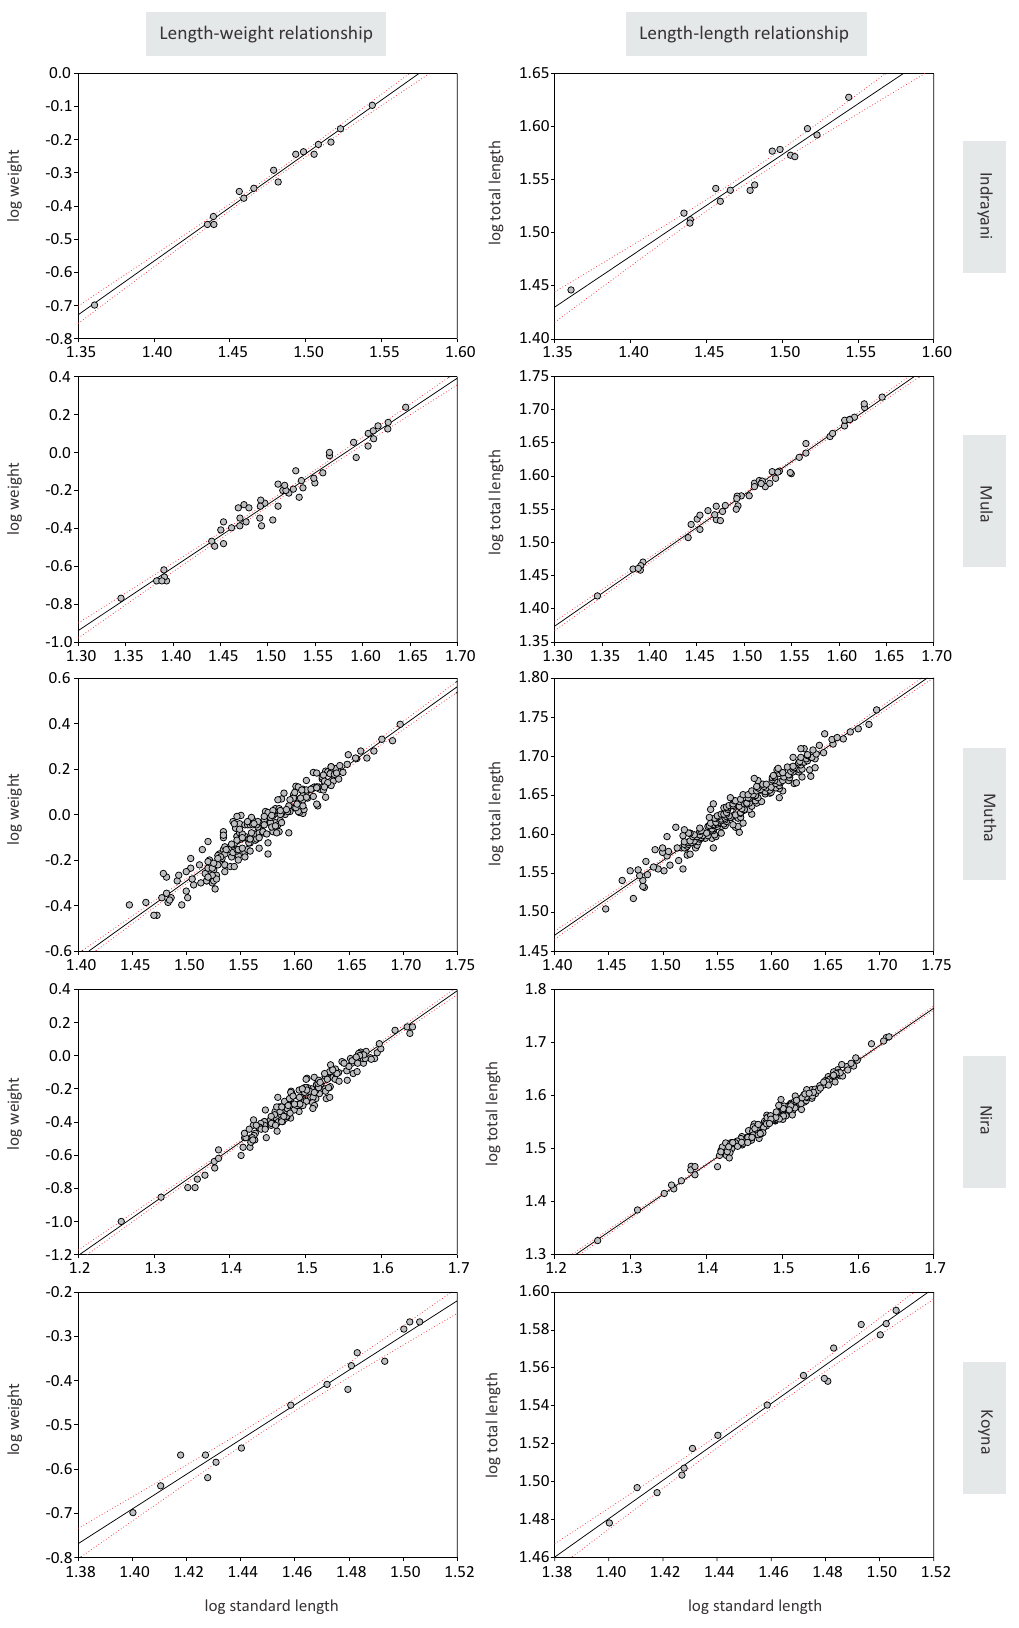
Appendix D. Scatter plots for Indoreonectes evezardi . Dashed lines are 95% confidence intervals for the regression